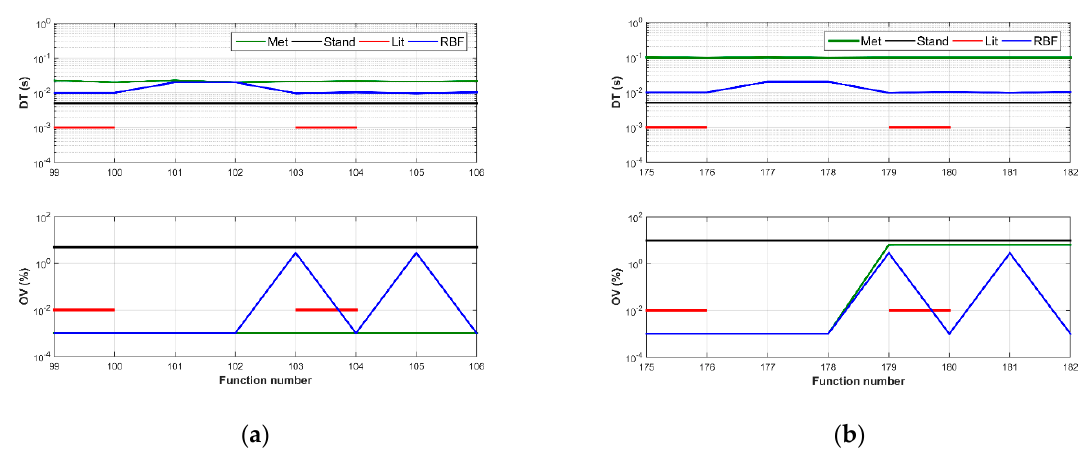
Figure 6. The DT and OV graphs for subsequent functions: ( a ) data for the P class of the PMU device; ( b ) data for the M class of the PMU device.